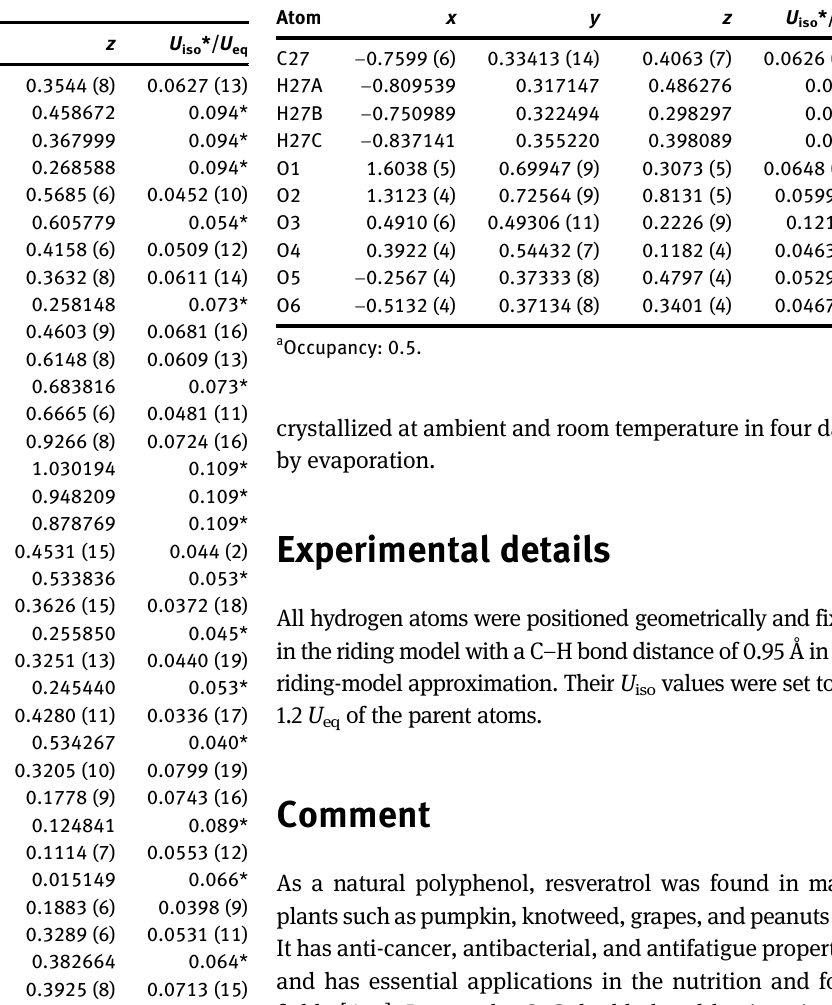
Table  : Fractional atomic coordinates and isotropic or equivalent isotropic displacement parameters (Å 